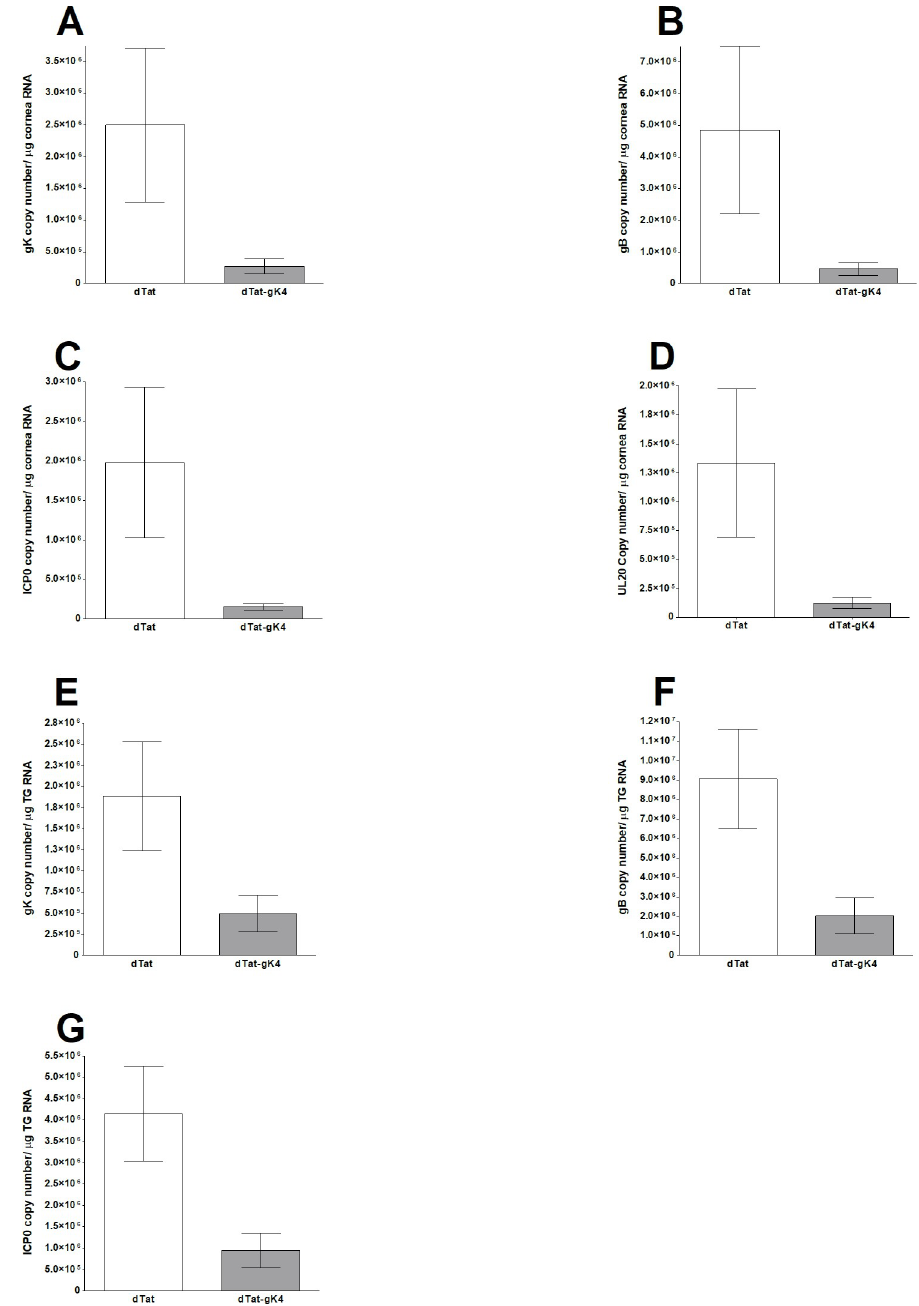
Fig 7. Expression of gK, UL20, ICP0, and gB transcripts in cornea and TG of ocularly infected mice in the presence of dTat-gK4. BALB/c mice were ocularly infected with 1 X10 5 PFU/eye of HSV-1 strain McKrae and treated with dTat-gK4 or dTat control peptide as described in Materials and Methods. Levels of gK, UL20, ICP0, and gB transcripts in the cornea and TG were determined on day 4 PI by qRT-PCR. Estimated relative copy number of HSV-1 UL20, gK, ICP0 and gB was calculated using standard curves generated from pUL20 [14], pAC-gB1 [65], pAc-gK1 [6], and pcDNA3.1-ICP0 [61]. Briefly, a DNA template, serially diluted 10-fold such that 1 μ l contained from 10 3 to 10 11 copies of each plasmid, was amplified by TaqMan PCR with the same primer set. Copy number of each reaction was determined by comparing the C T of each sample to the threshold cycle of the standard. GAPDH expression was used to normalize relative expression of each transcript in the cornea and TG of infected mice. Each bar represents mean ± SEM from five mouse corneas or TG. Panels: (A) gK expression in cornea; (B) gB expression in cornea; (C) ICP0 expression in cornea; (D) UL20 expression in cornea; (E) gK expression in TG; (F) gB expression in TG; and (G) ICP0 expression in